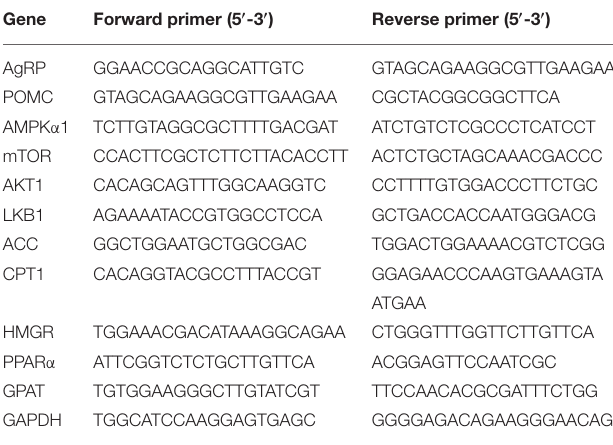
TABLE 1 | Gene primer sequences used in quantitative